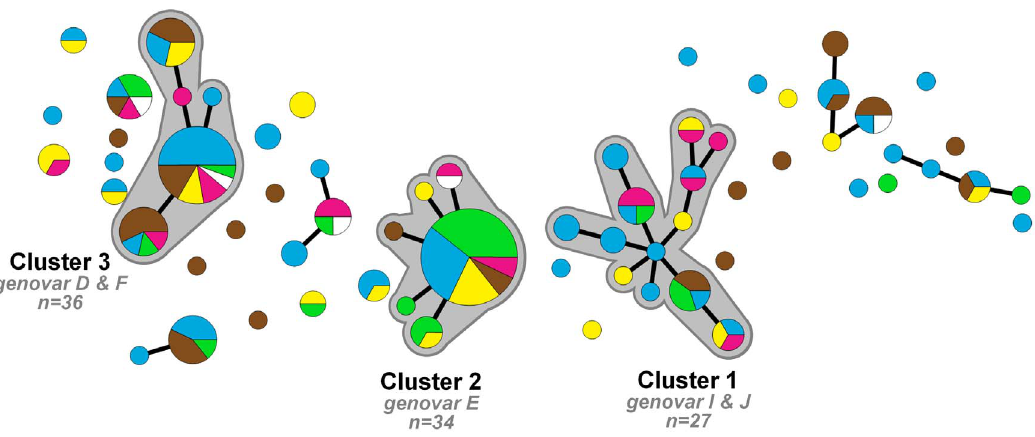
Figure 1. Minimum spanning tree of 170 Chlamydiatrachomatis positive samples in Paramaribo, Suriname 2008–2010. Each circle represents one MLST type. Size of the circles is proportional to the number of identical MLST profiles. Bold lines connect types that differ by one single locus. Halos indicate the three large distinct clusters ( $ 27 samples). Colors indicate ethnicity; blue – Creole, brown – mixed race, green – Javanese, yellow – Maroon, pink – Hindustani, white – Indigenous Amerindian, Caucasian and unknown.